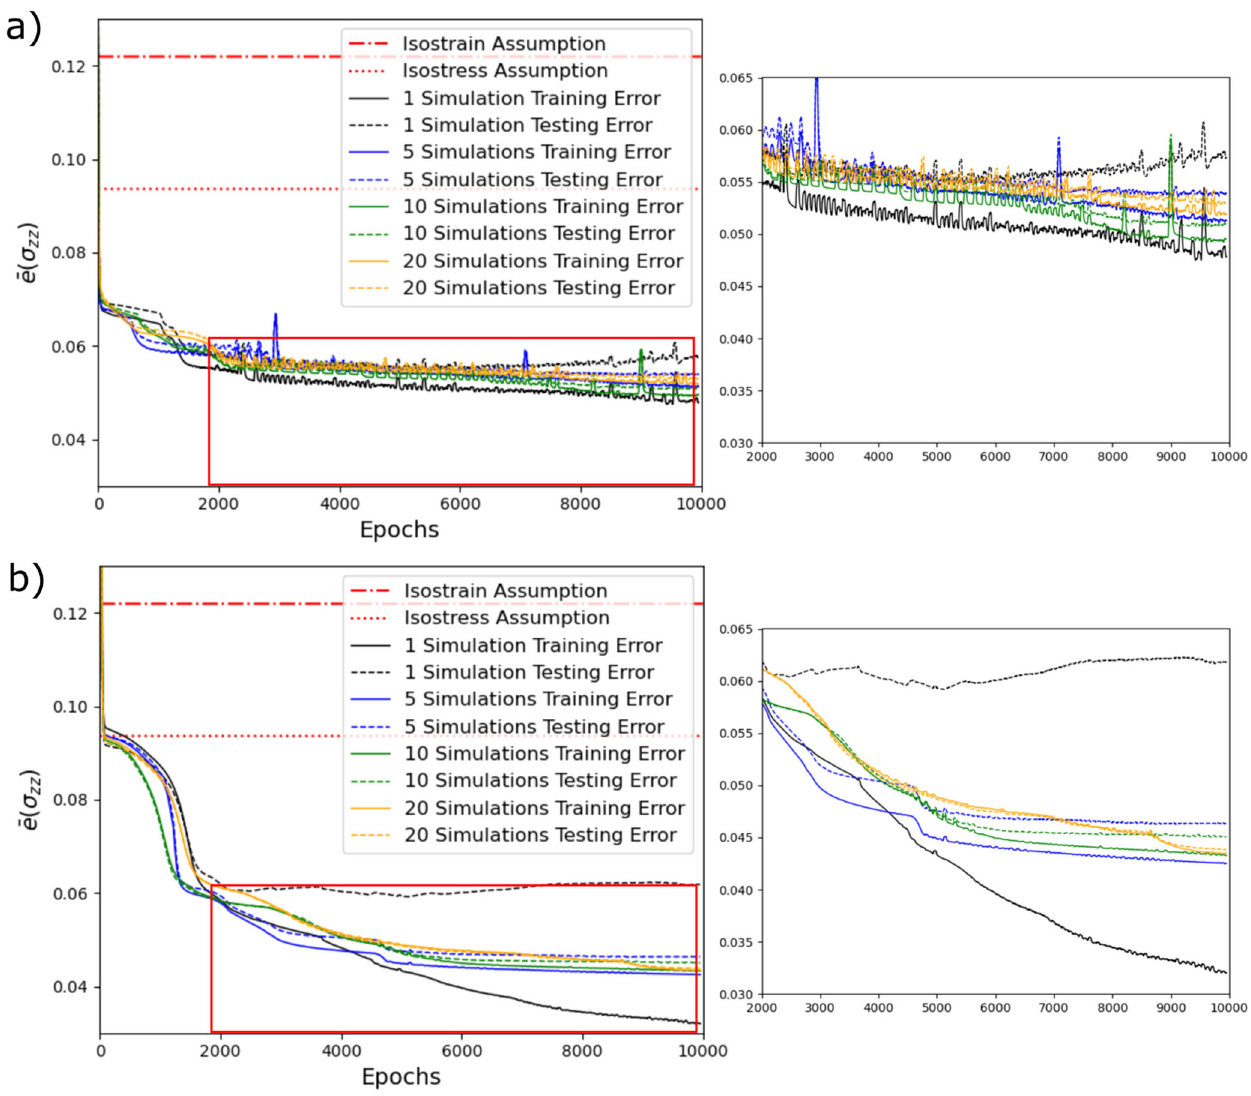
Fig. 1 Learning rates of LSHR grain-scale elastic response using various numbers of CEFEM simulations for training and testing. Insets show a magni fi ed view of the learning rate at larger epochs. a Learning rates using the directional modulus E ( r ) as a nodal feature. b Learning rates using the lattice orientation (components of the Rodrigues vector r ) as nodal